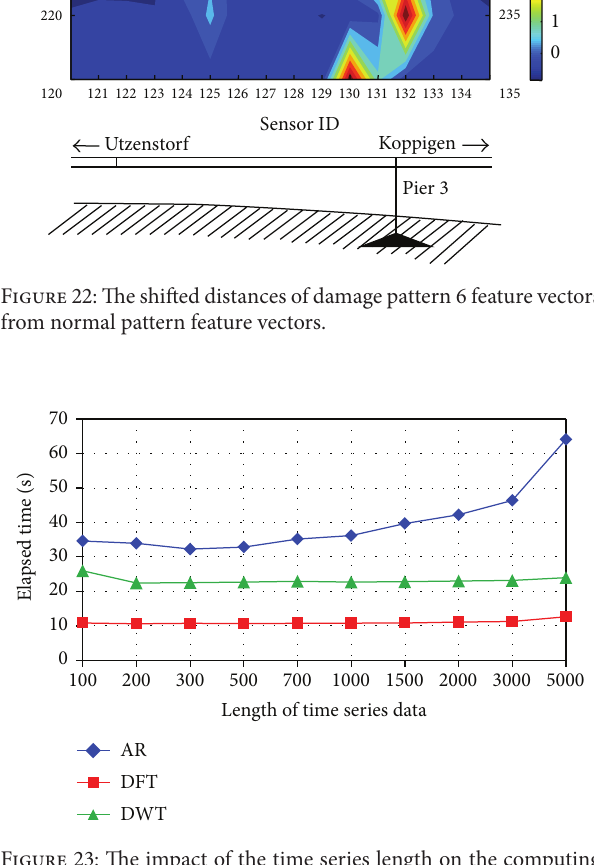
Figure 23: The impact of the time series length on the computing time for different feature extraction